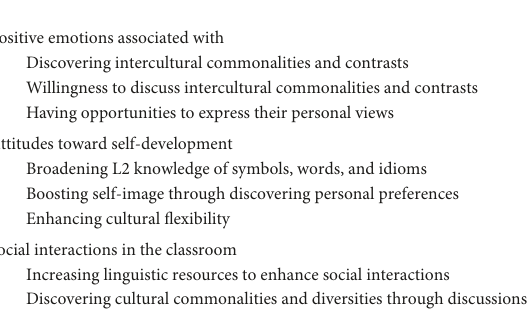
TABLE 5 Emerging cross-case themes of the target story-based phase. Positive emotions associated with Discovering intercultural commonalities and contrasts Willingness to discuss intercultural commonalities and contrasts Having opportunities to express their personal views Attitudes toward self-development Broadening L2 knowledge of symbols, words, and idioms Boosting self-image through discovering personal preferences Enhancing cultural flexibility Social interactions in the classroom Increasing linguistic resources to enhance social